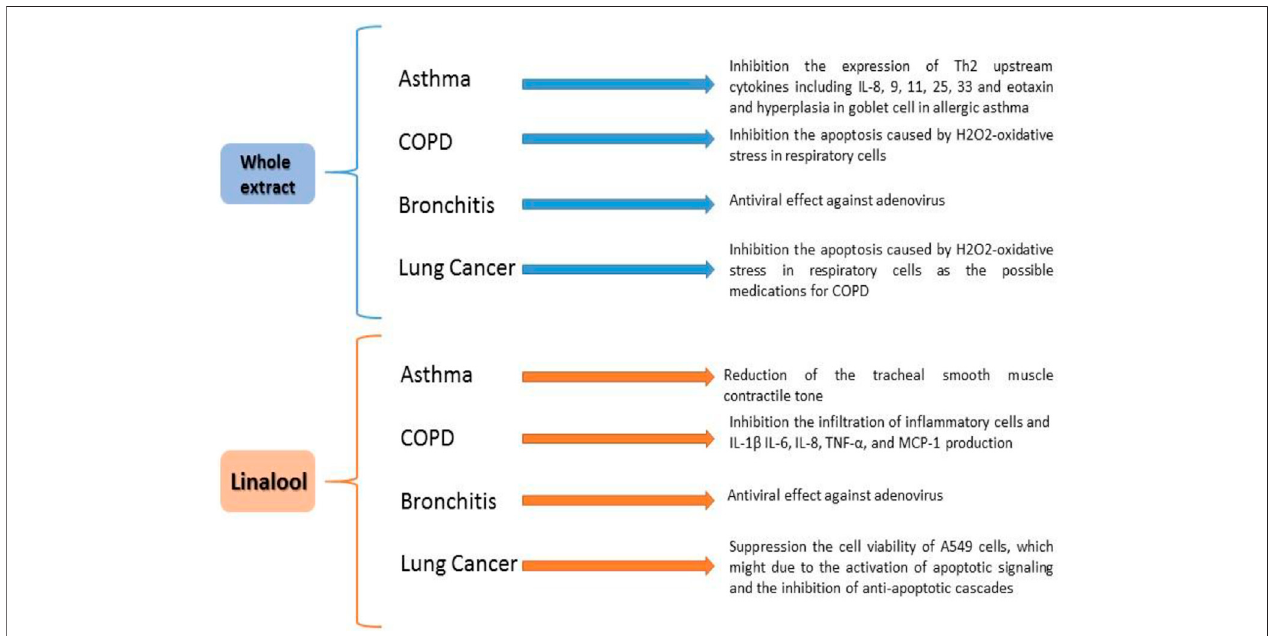
FIGURE 2 | Effects of Ocimum basilicum and linalool on respiratory